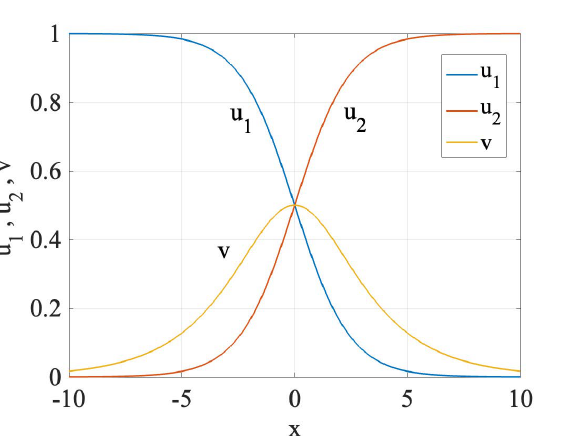
Figure 5. An example of the exact solution for the DW–bright-soliton complex, given by Equa- tions (72) and (73), for g = 7/6, G = 11/6, and D =